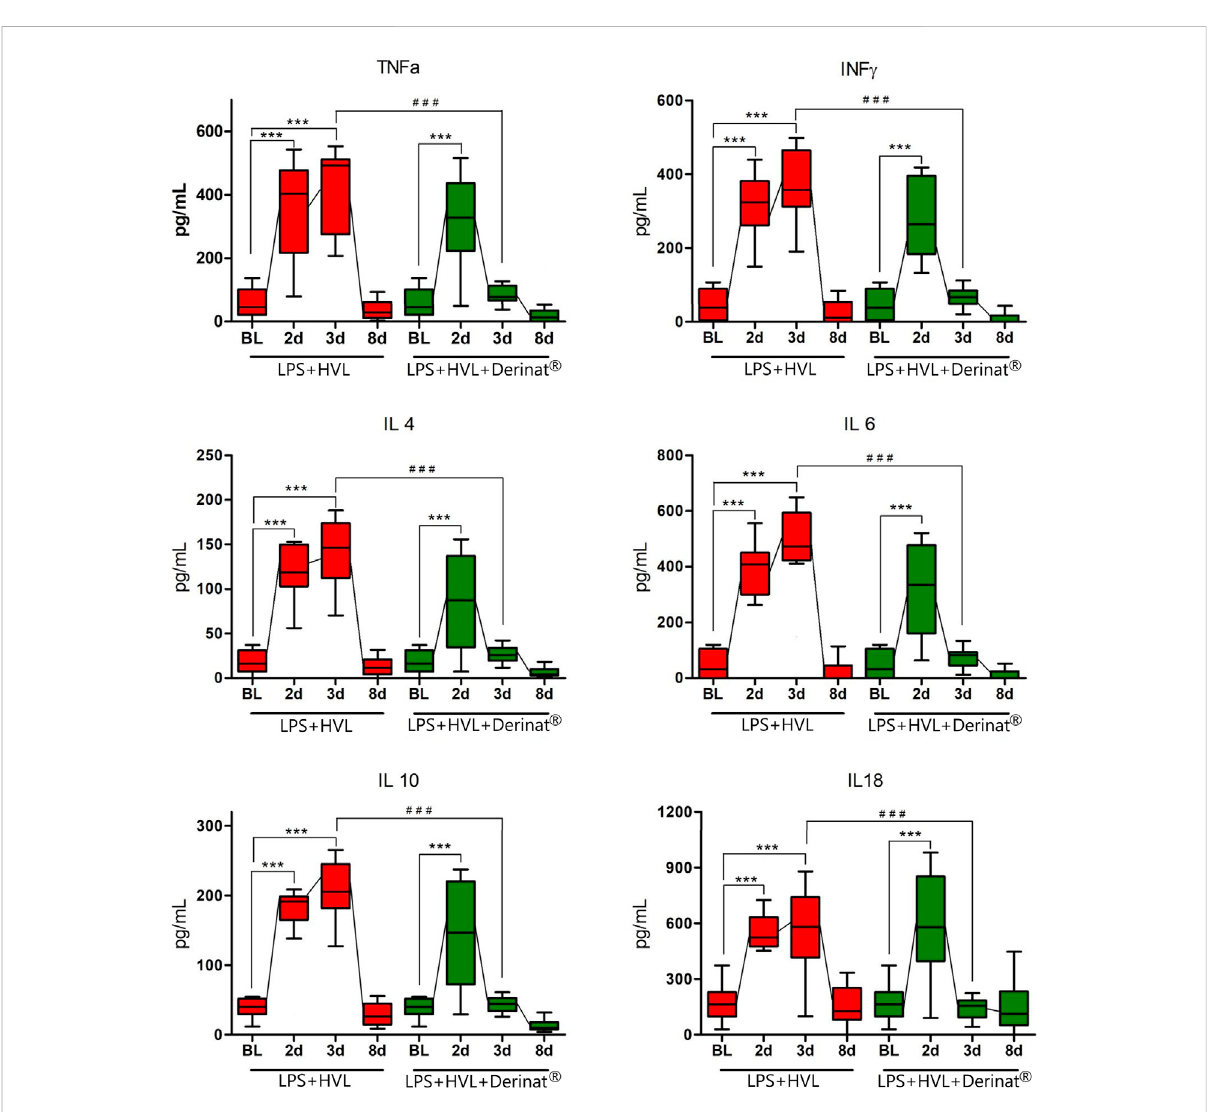
FIGURE 4 Dynamics of changes in the concentration of some cytokines (TNF α , IFN γ , IL-4, IL-6, IL-10, IL-18) in the blood plasma of SD rats on the background of the introduction of saline or Derinat ® . BL – Baseline (value prior ALI modeling); 2d, 3d, 8d after ALI simulation. # p ≤ 0.05, ## p ≤